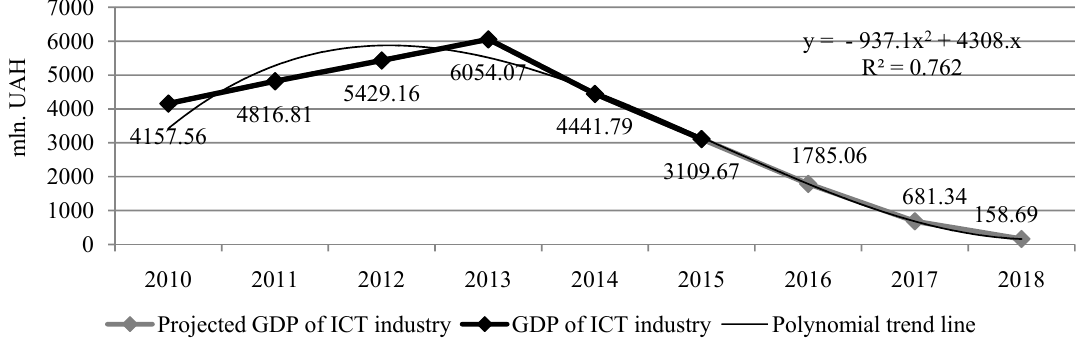
Fig. 5. Predictive value of IT market volume according to logarithmic trend line in